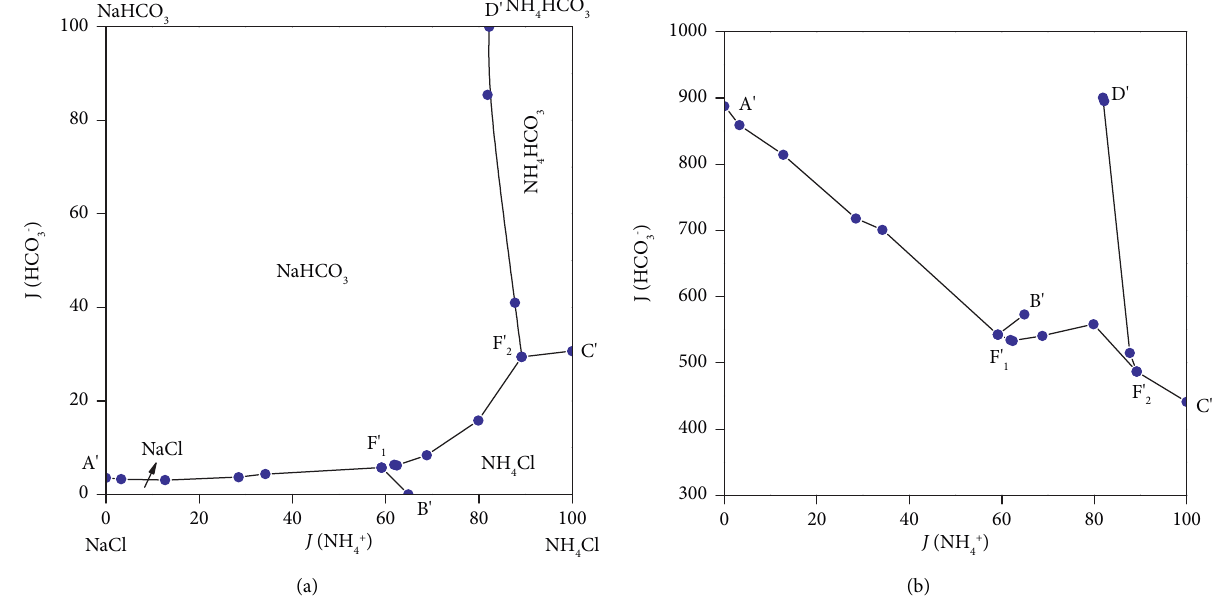
Figure 2: Phase diagram of the quaternary system (Na + , NH 4+ //Cl − , and HCO content diagram.